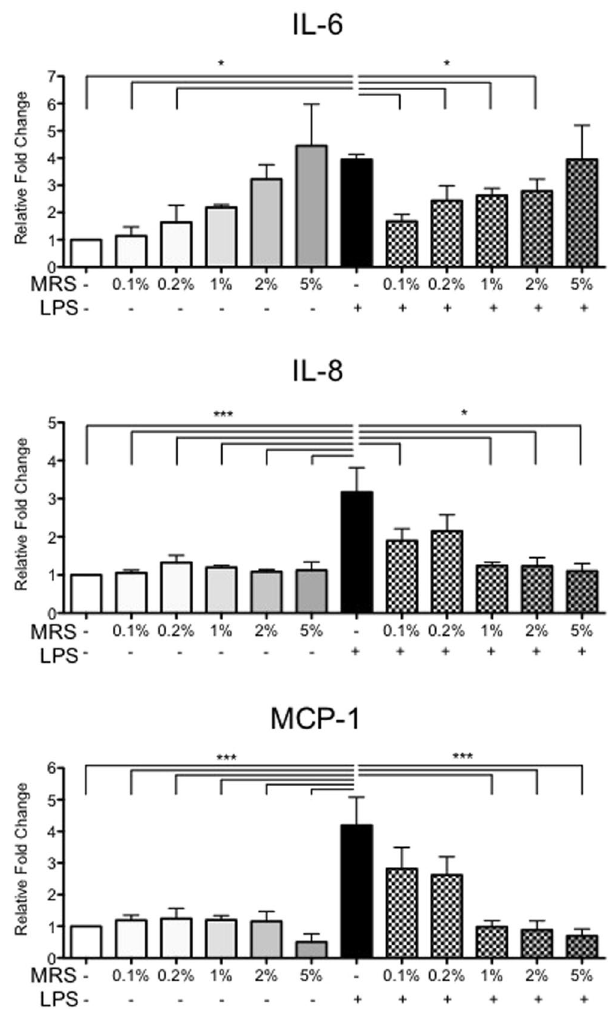
Figure 3. Effect of MRS broth on cytokine secretion in hTERT-HM. hTERT-HM cells were treated with various doses of MRS broth (0.1–5% v/v) without LPS stimulus (solid grey bars) or for 16 hours prior to (checkered grey bars). Values are presented as fold change (mean ± SEM) relative to untreated control (solid white bars). Statistical significance was determined by One-way ANOVA followed by Dunnett’s post-test relative to LPS stimulus (100 ng/mL, solid black bar). * P < 0.05; ** P < 0.01; *** P < 0.001 (n =